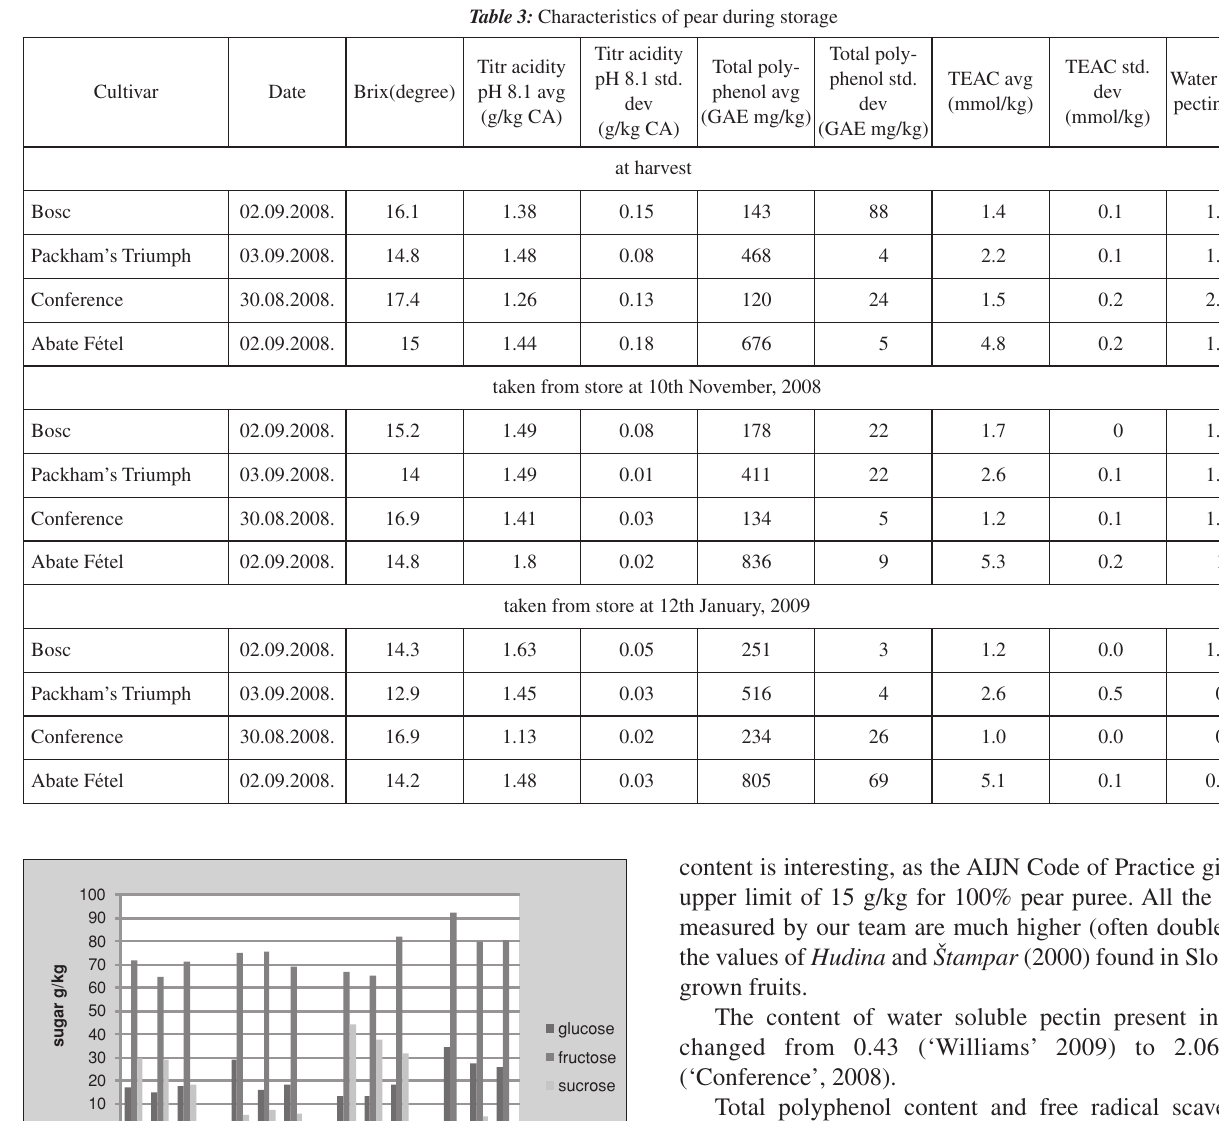
Table 3: Characteristics of pear during storage